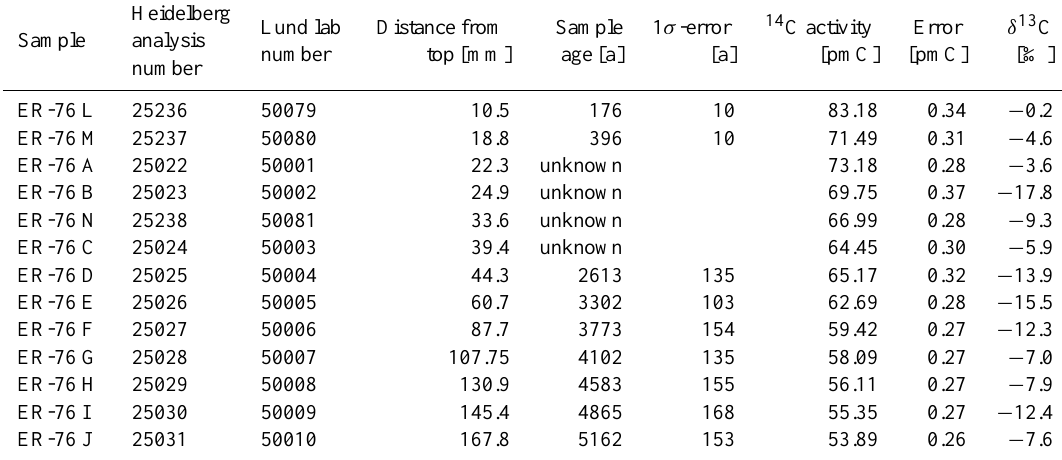
Table 2. Results of 14 C dating.